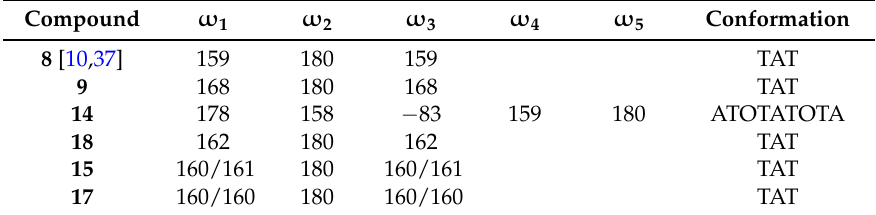
Figure 13. Crystal structure of 15 . Thermal ellipsoids are represented at the 30% level and hydrogen atoms have been omitted for clarity (bond lengths in Å, angles in deg). Si(6)-Si(9) 2.3357(19), Si(6)-Si(8) 2.3460(17), Si(6)-Si(7) 2.357(2), Si(6)-Si(10) 2.3694(17), Si(7)-C(18) 1.869(6), Si(9)-Si(6)-Si(8) 107.60(7), Si(9)-Si(6)-Si(7) 109.89(7), Si(8)-Si(6)-Si(7) 105.08(7), Si(9)-Si(6)-Si(10) 114.57(6), Si(8)-Si(6)-Si(10) 112.08(7), Si(7)-Si(6)-Si(10) 107.21(6). Table 2. Conformational properties of oligosilanes described as the torsional angles of the main chain.